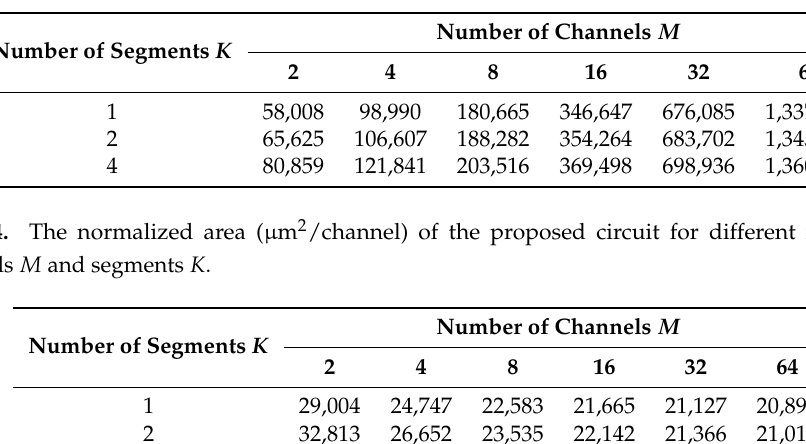
Table 3. The area ( µ m 2 ) of the proposed circuit for different numbers of channels M and segments K .